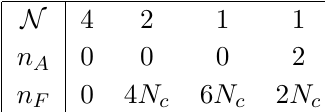
Table 1 . The four solutions to the constraints in eq. (6.17) into eq. (6.8) and (6.9). It is easy to see that theories with ( N ; n ; n ) = (4 ; 0 ; 0) have the same (cid:12)eld content as N = A F 4 SYM, and so N = 4 SYM satis(cid:12)es all the constraints, as expected. Similarly, theories with ( N ; n ; n ) = (2 ; 0 ; 4 N ) have the same (cid:12)eld content as N = 2 superconformal c A F